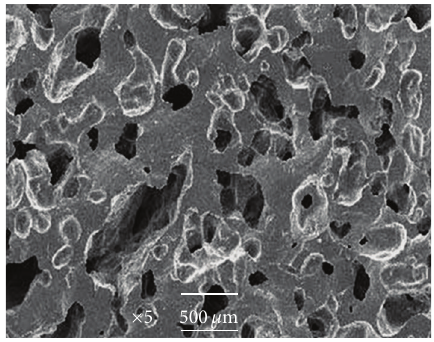
Figure 1: SEM micrographs of porous n-HA/PA66.